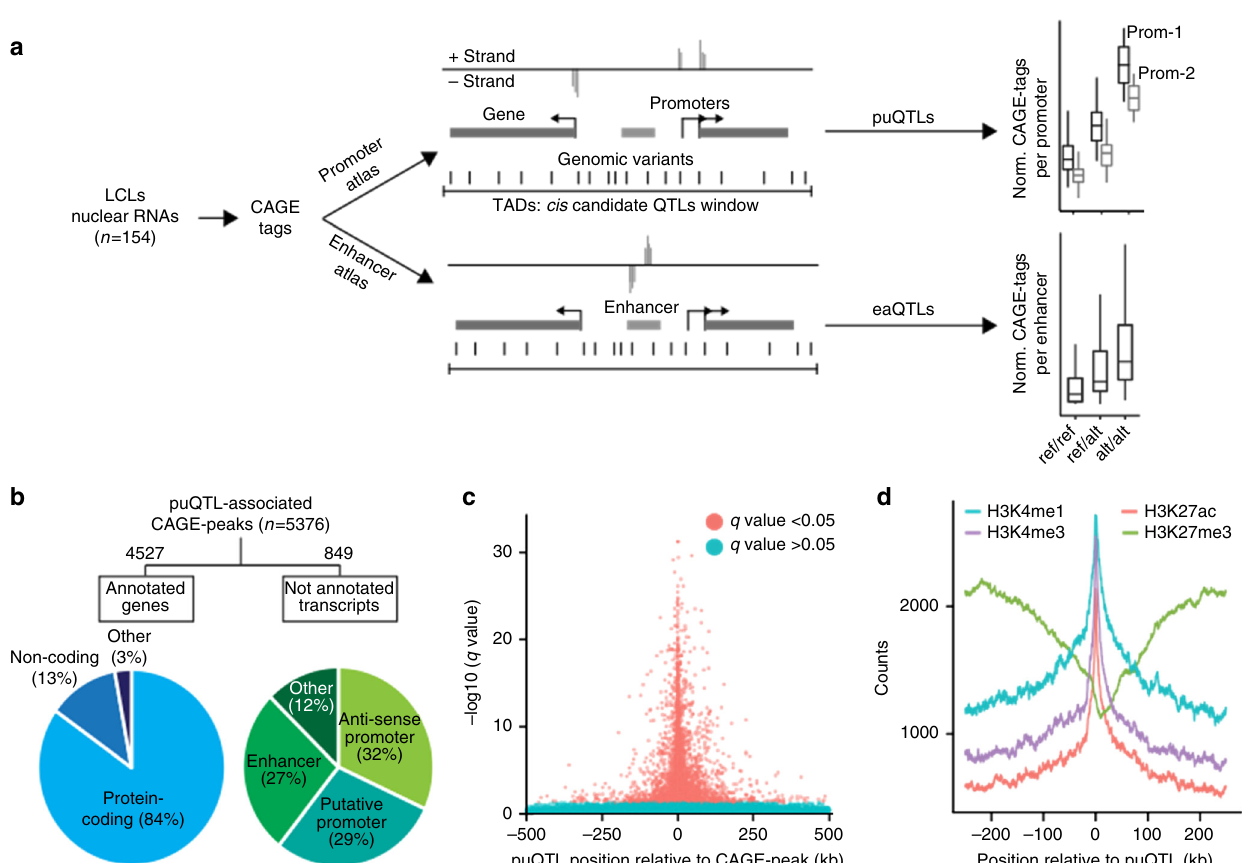
Fig. 1 Study design and puQTLs mapping. a Experimental design for the promoter usage and enhancer activity QTL mapping. b Annotation of puQTL- associated CAGE peaks with functional genomic regulatory elements and genomic localization respective to annotated transcripts from GENCODE-V19. c Signi fi cance relative to distance for each promoter (CAGE peaks) with best-associated puQTL plotted for 1 Mb window. d Total counts of histone marks ChIP-seq signals (GM12878 cells, ENCODE data) for the 500 kb regions fl anking